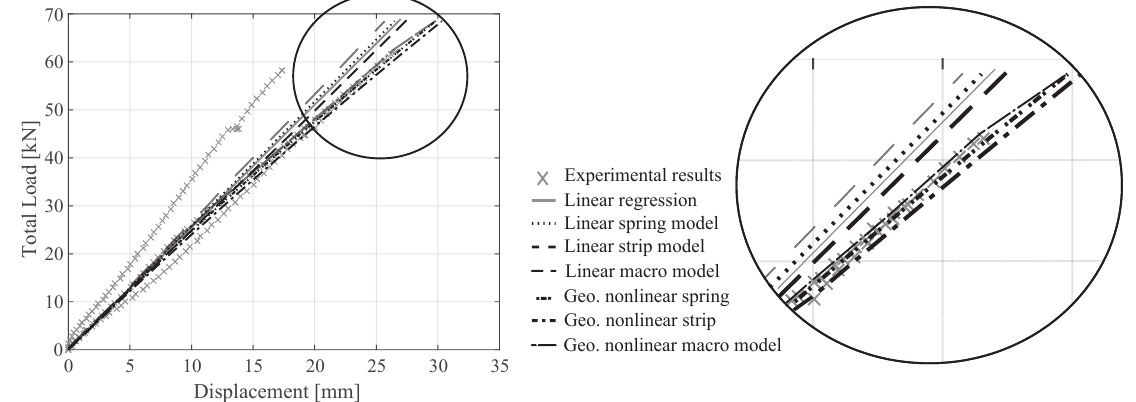
Figure 17. Comparison of experimental and numerically obtained results. Total load vs. maximum vertical displacement.